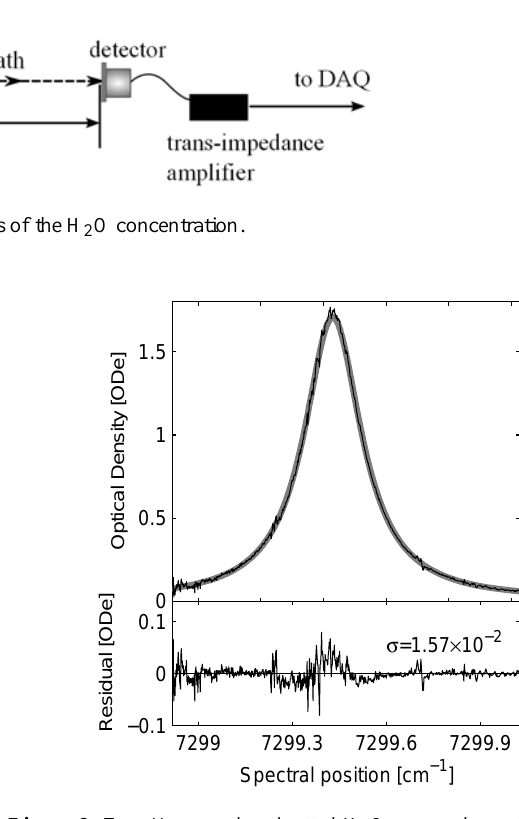
Figure 3. Top: Measured and fitted H 2 O vapor absorption signal (unaveraged) while continuously spatially scanning the laser beam at 1.25Hz field measurement rate. The laser wavelength tuning rate amounted 5039.8Hz. Bottom: residual between fit and measured signal. Concentration amounted 12038ppmv at an absorption path length of 1.98m, temperature of 293.5K and pressure of